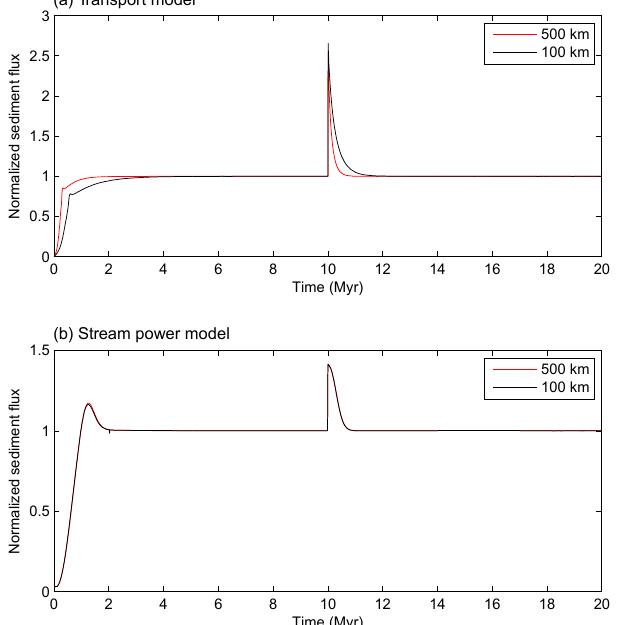
Figure 11. (a) Response of the transport model to a change in precipitation rate for two different model dimensions, 100 by 100km and 500 by 500km. Equation (6) is solved for δ = 1 . 5 and c = 1 × 10 − 4 (m 2 yr − 1 ) 1 − δ . The precipitation rate is initially α 0 = 1myr − 1 and changes to α 1 = 2myr − 1 after 10Myr. (b) Re- sponse of the stream power model to a change in precipitation rate for two different model dimensions, 100 by 100km and 500 by 500km. Equation (6) is solved for m = 0 . 5 and k = 1 × 10 − 5 m − 1 (m 2 yr − 1 ) 1 − m . The precipitation rate is initially α 0 = 1myr − 1 and changes to α 1 = 2myr − 1 after 10Myr.